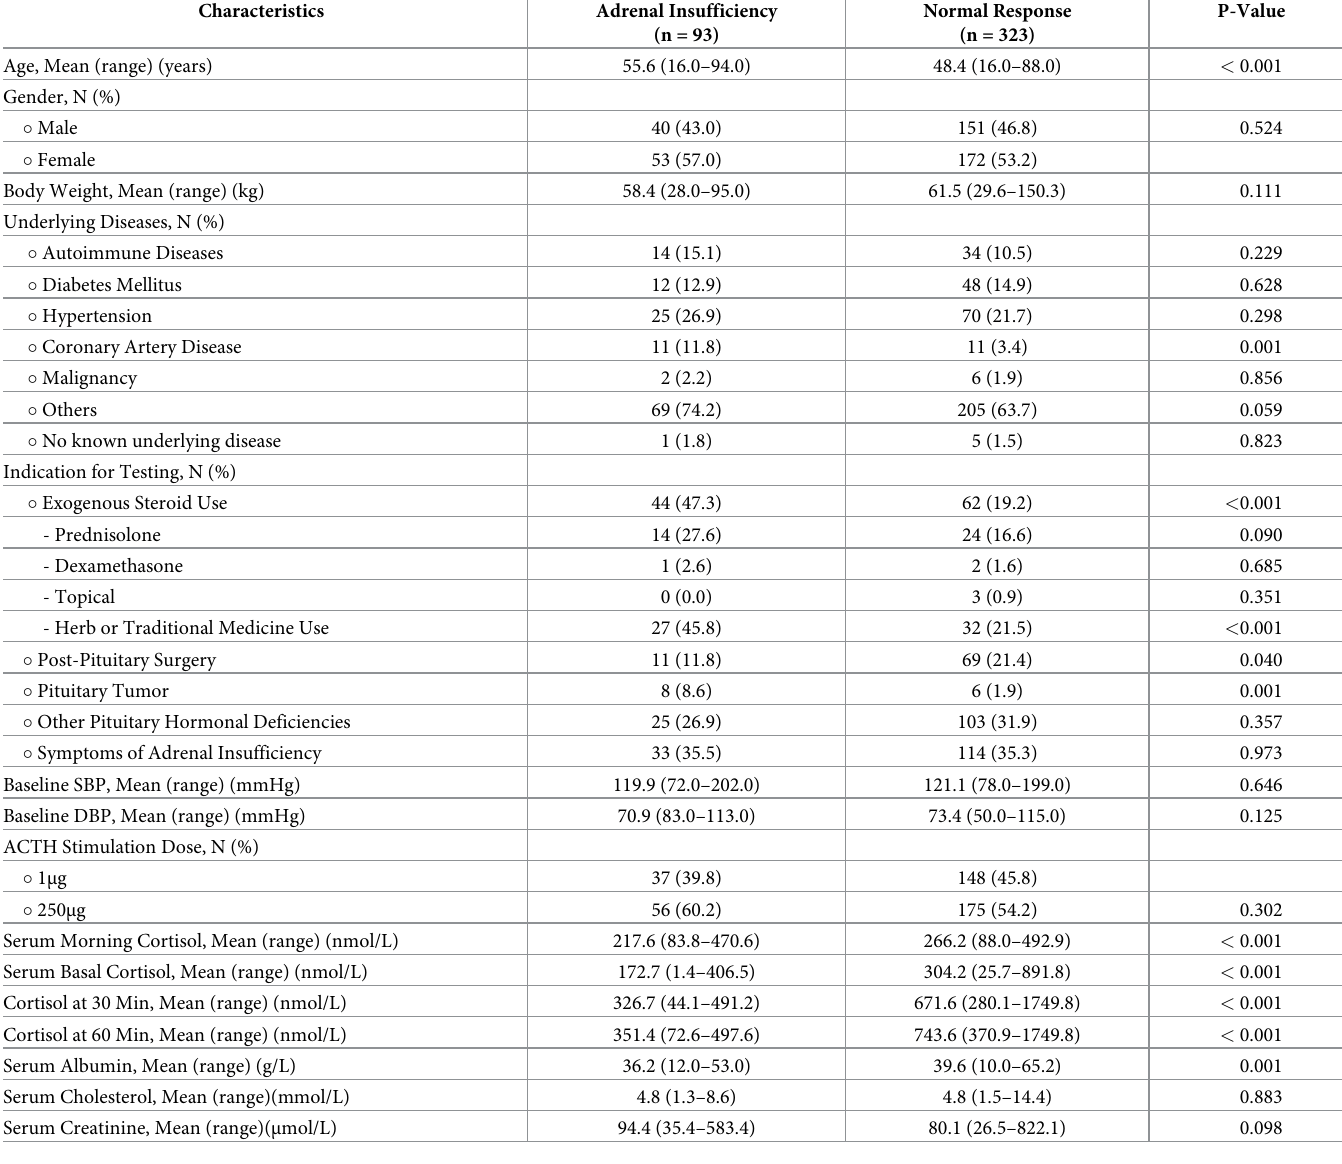
Table 1. Baseline